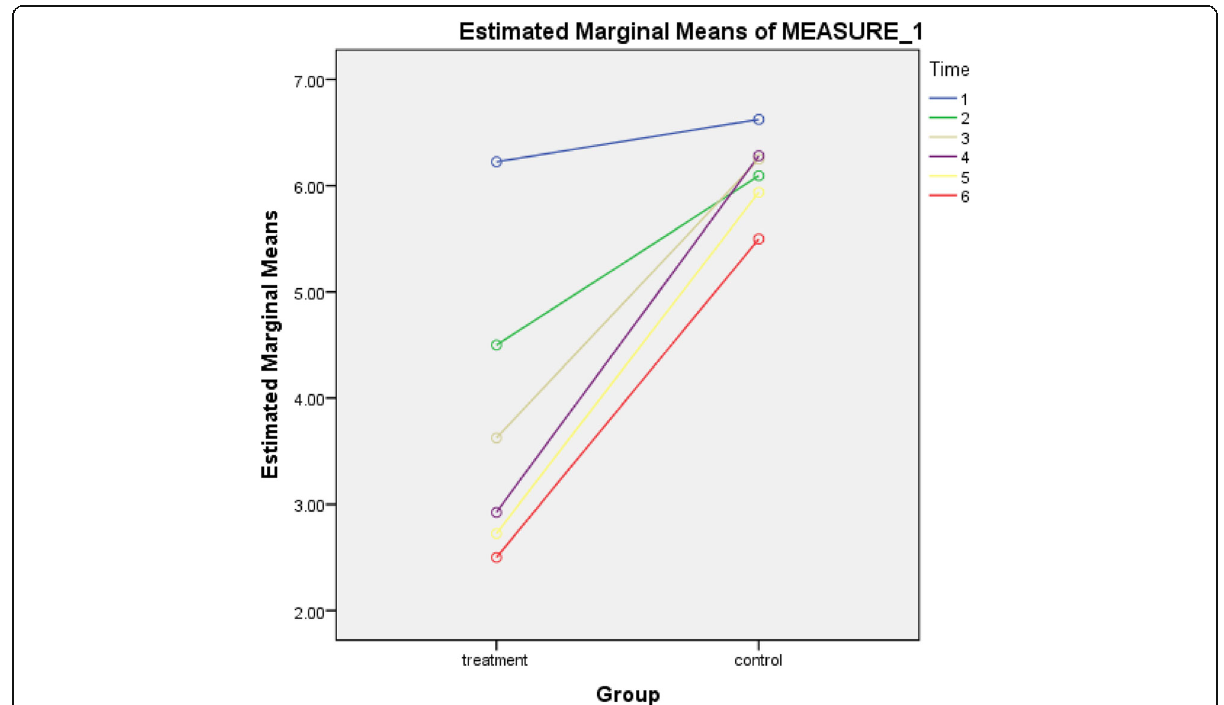
Fig. 5 Subjects selection flow chart. Test group: 5 subjects absconded without any known reason, 10 subjects were irregular in attendance and the total that did not complete the study was 15. The total number that was eventually analyzed was 40. Control group: 6 subjects absconded without any known reason, 17 subjects were irregular attendance, and the total number that did not complete the study was 23 subjects. The total number that was eventually analyzed was 32